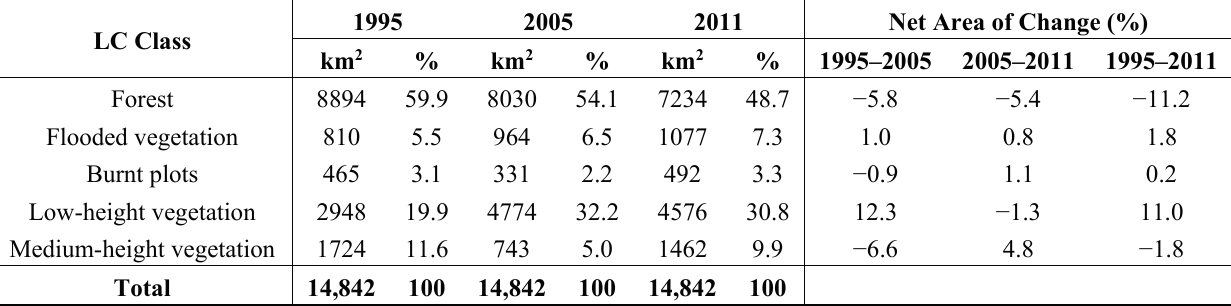
Table 4. LC shares (in km 2 and percentage of total analysed area) and net area of change (as percentage of total analysed area) for the years 1995, 2005, and